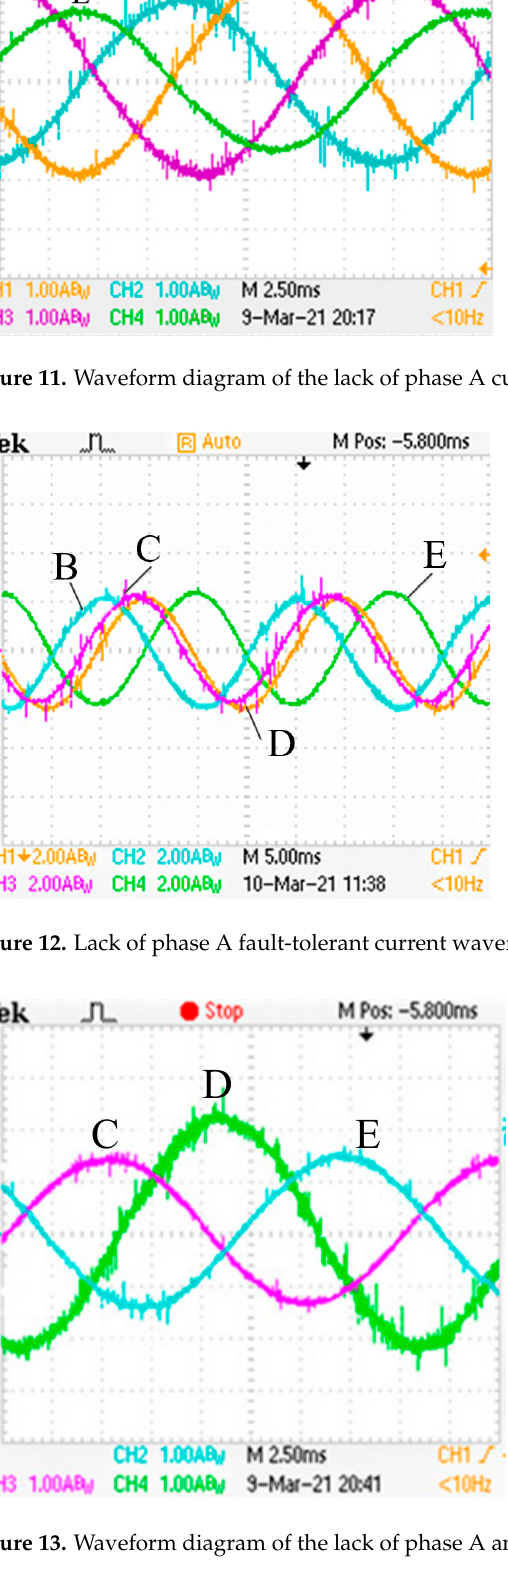
E Figure 14. Lack of phase A and B fault − tolerant current waveform. B E Figure 15. Waveform diagram of the lack of phase A and C current experiment.